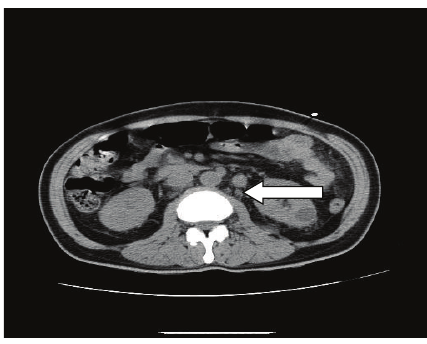
Figure2:CTofabdomenwithoutcontrastshowinglymphadenopa- thy.